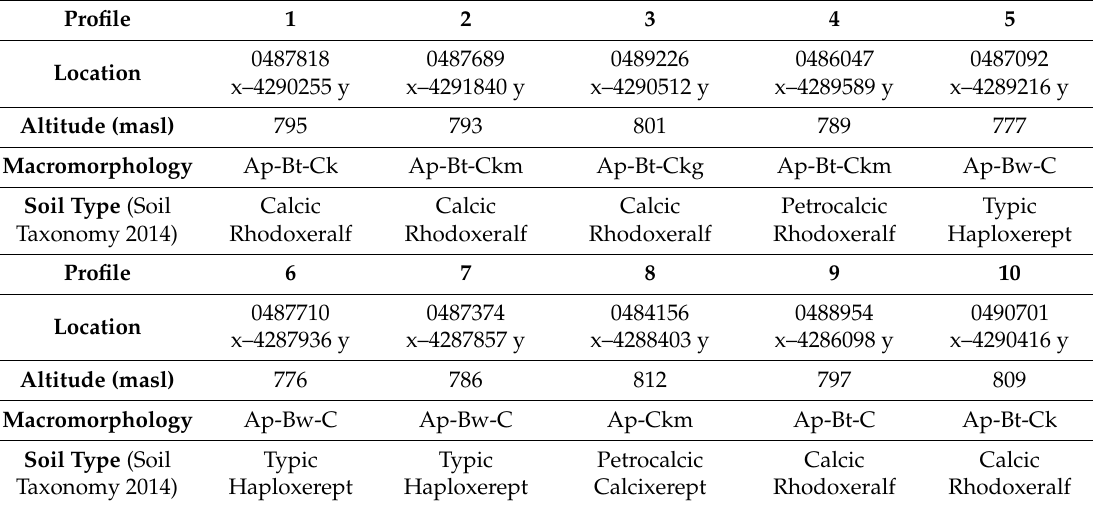
Table 1. Some data description of the studied soils; (masl) = meters above sea